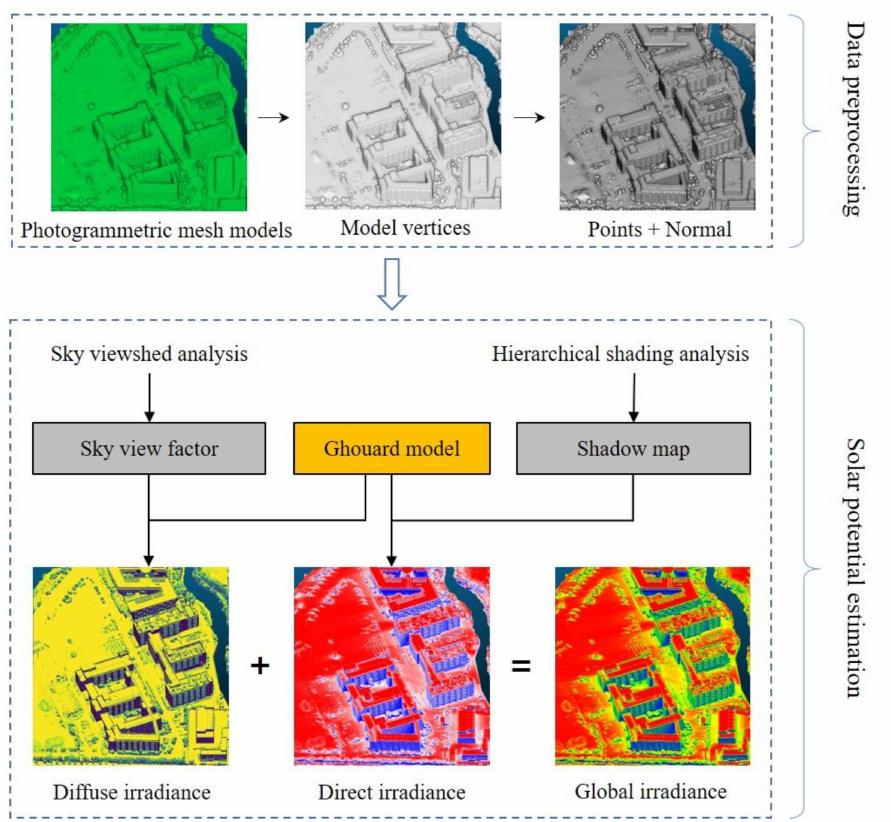
Figure 1. The flowchart of the proposed